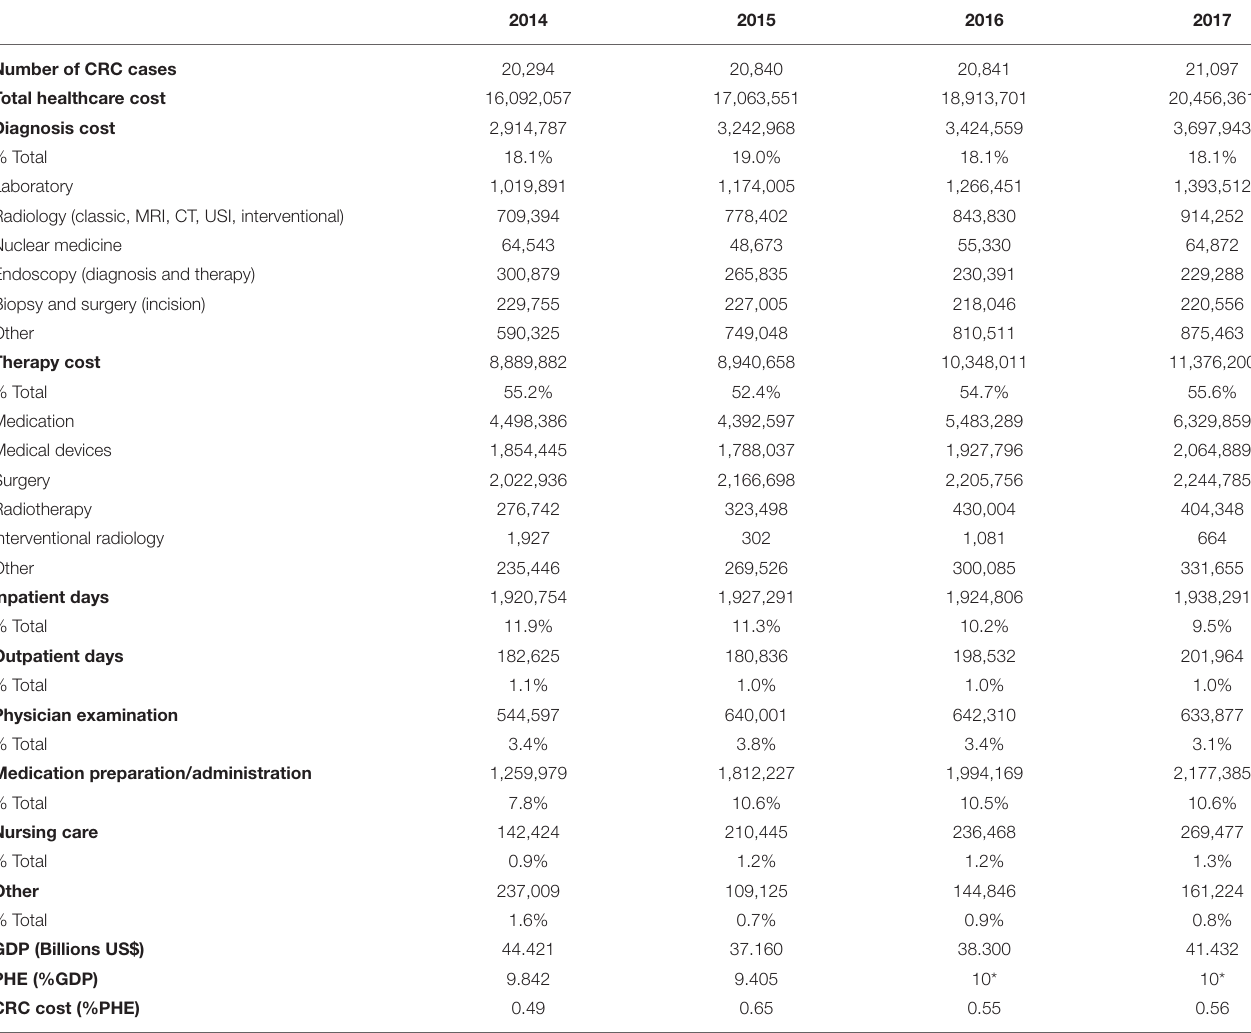
TABLE 1 | The number of cases of colorectal cancer (CRC) in Serbia, the associated annual cost ( e ) by healthcare services, and the national economic indicators during the 4-year study